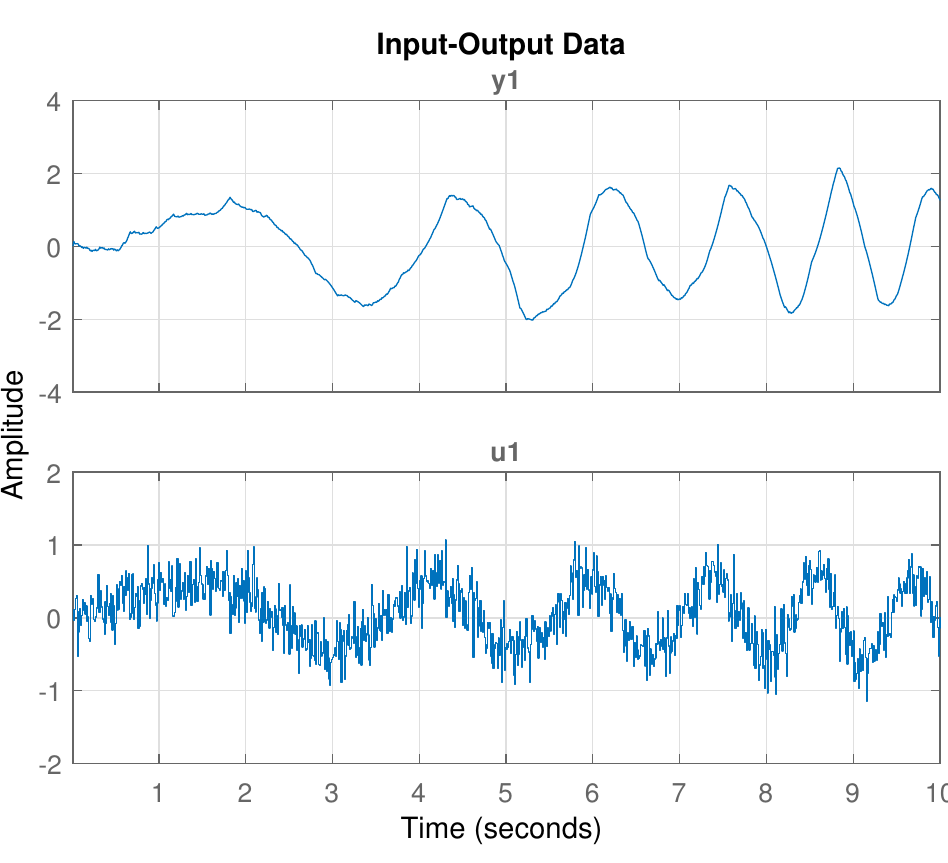
Figure 3. Identification data-set. Above is directional spool position. Below is duty of the pulse width modulated signal applied to the switching valve